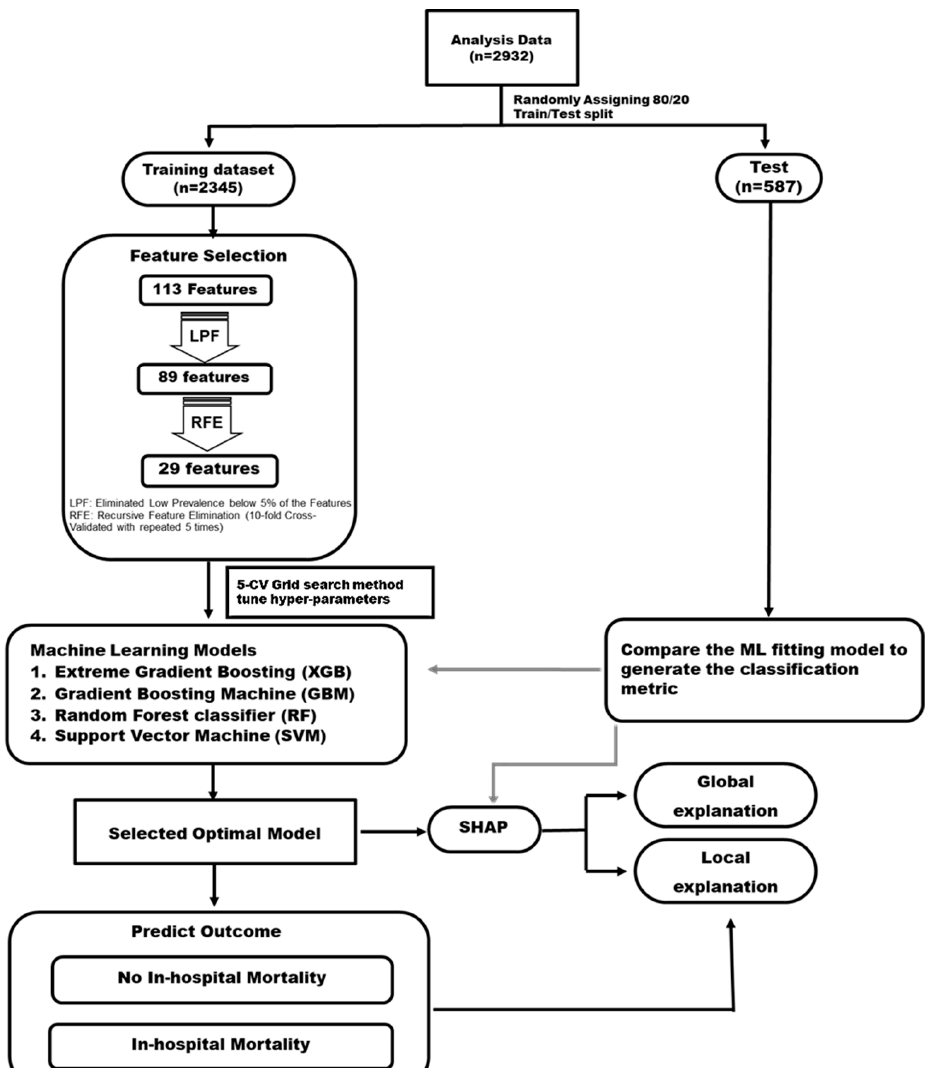
Figure 2. Study framework and feature engineering.